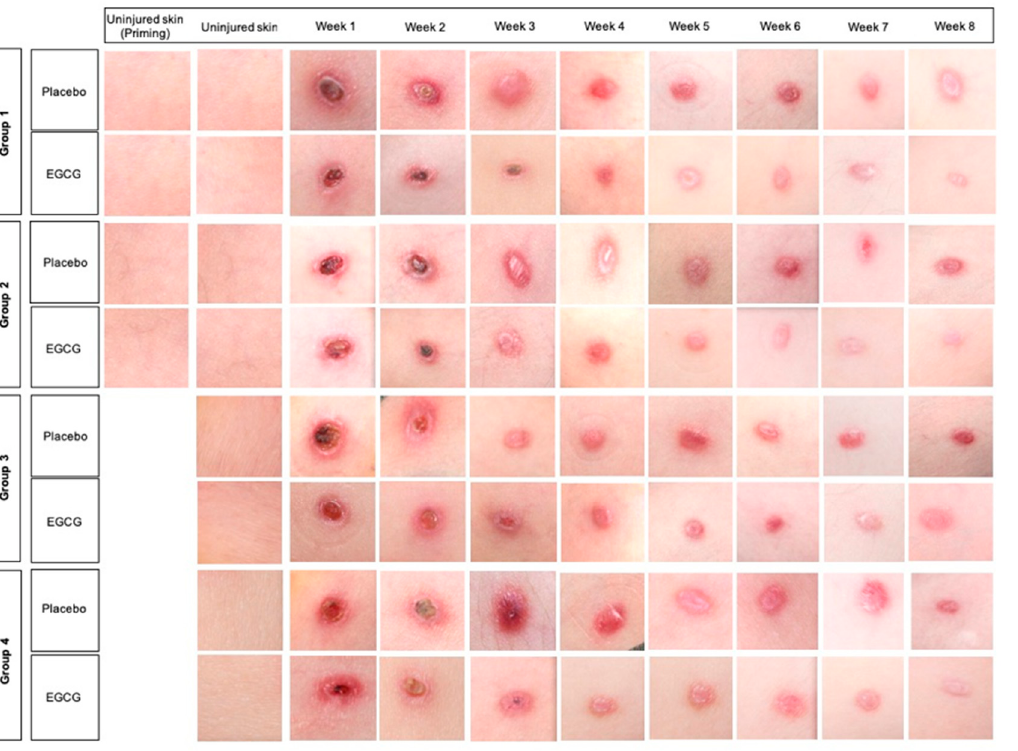
Figure 12. Clinical images of the scar sites over 8 weeks for each of the groups. Scars healed well in all groups and with both topical formulations. Scars were slightly paler in color with EGCG compared to placebo. No great visual differences were noted between the groups.